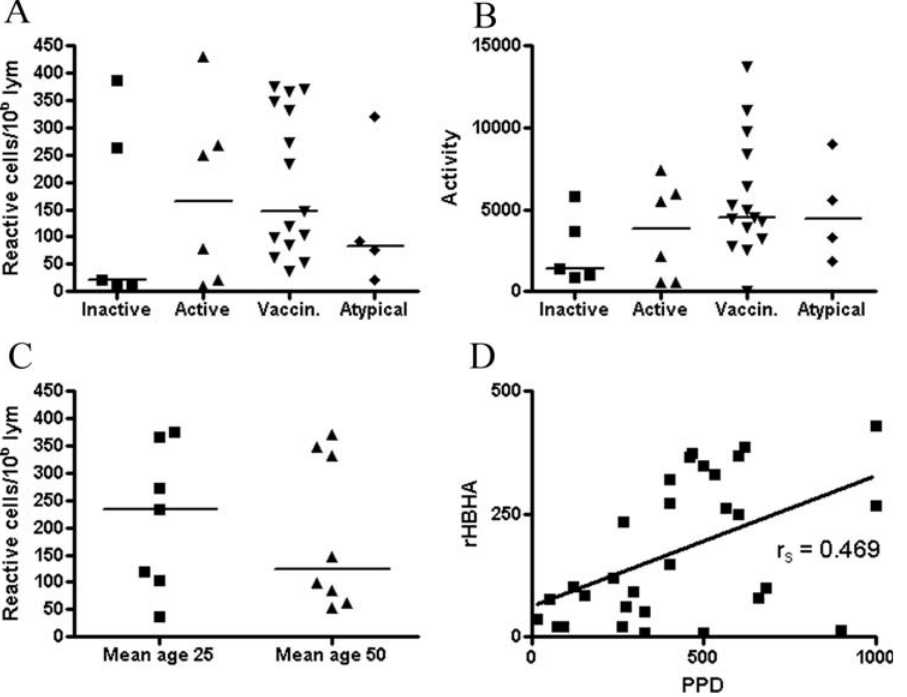
Figure 1. The ability of rMtb-HBHA and PPD to induce the production of IFN c was tested in the ELISPOT technique. The groups of patients with inactive TB (n=5); active TB (n=6), healthy young (n=7) and middle-age (n=8) vaccinated subjects and patients with isolation of so- called atypical mycobacteria (n=4) and were enrolled. Comparison of the cell-mediated immunological responses to rMtb-HBHA was performed as the determination of the number of reactive cells per10 6 lymphocytes (A) and as the measurement of IFN c production activities expressed as arbitrary units (B). Cell-mediated immunological responses in healthy vaccinated individuals was studied by division by age into two groups (C). The correlation of rMtb-HBHA with the PPD ELISPOT reactivities expressed as the frequencies of reactive cells per10 6 is presented in (D). Data are shown as individual reactivities; the horizontal bars represent arithmetic median values.